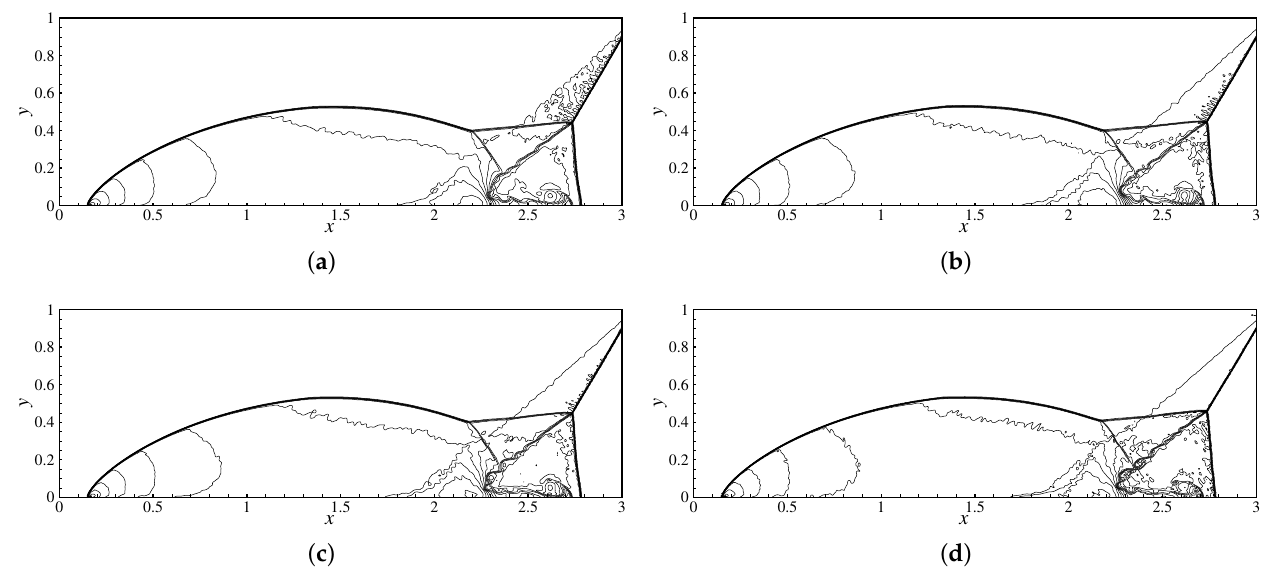
Figure 19. Density contours of the double Mach reflection problem with 961 × 241 grid points. 23 equally distributed contours ranging from 2.0 to 23.0: ( a ) WCNS5-JS; ( b ) WCNS5-Z; ( c ) WCNS5- AS; ( d ) WCNS5-AT.